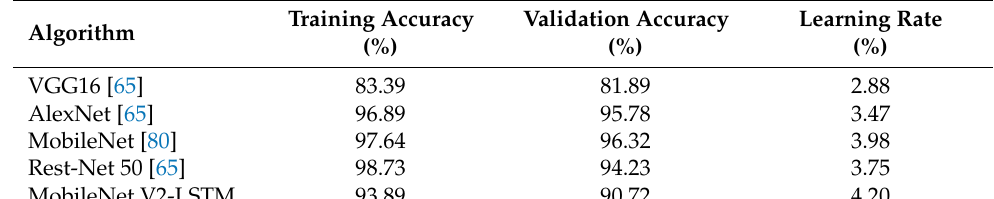
Figure 11. The progress of the disease growth.